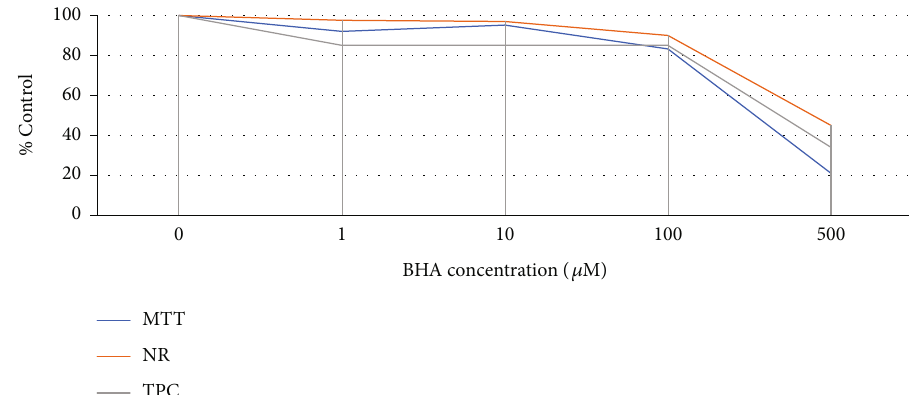
Figure 1: Results were obtained with the three basal cytotoxicity assays after 24 hours of exposure to BHA (ANOVA, p = 0 : 063 ). 100 ± 18.5